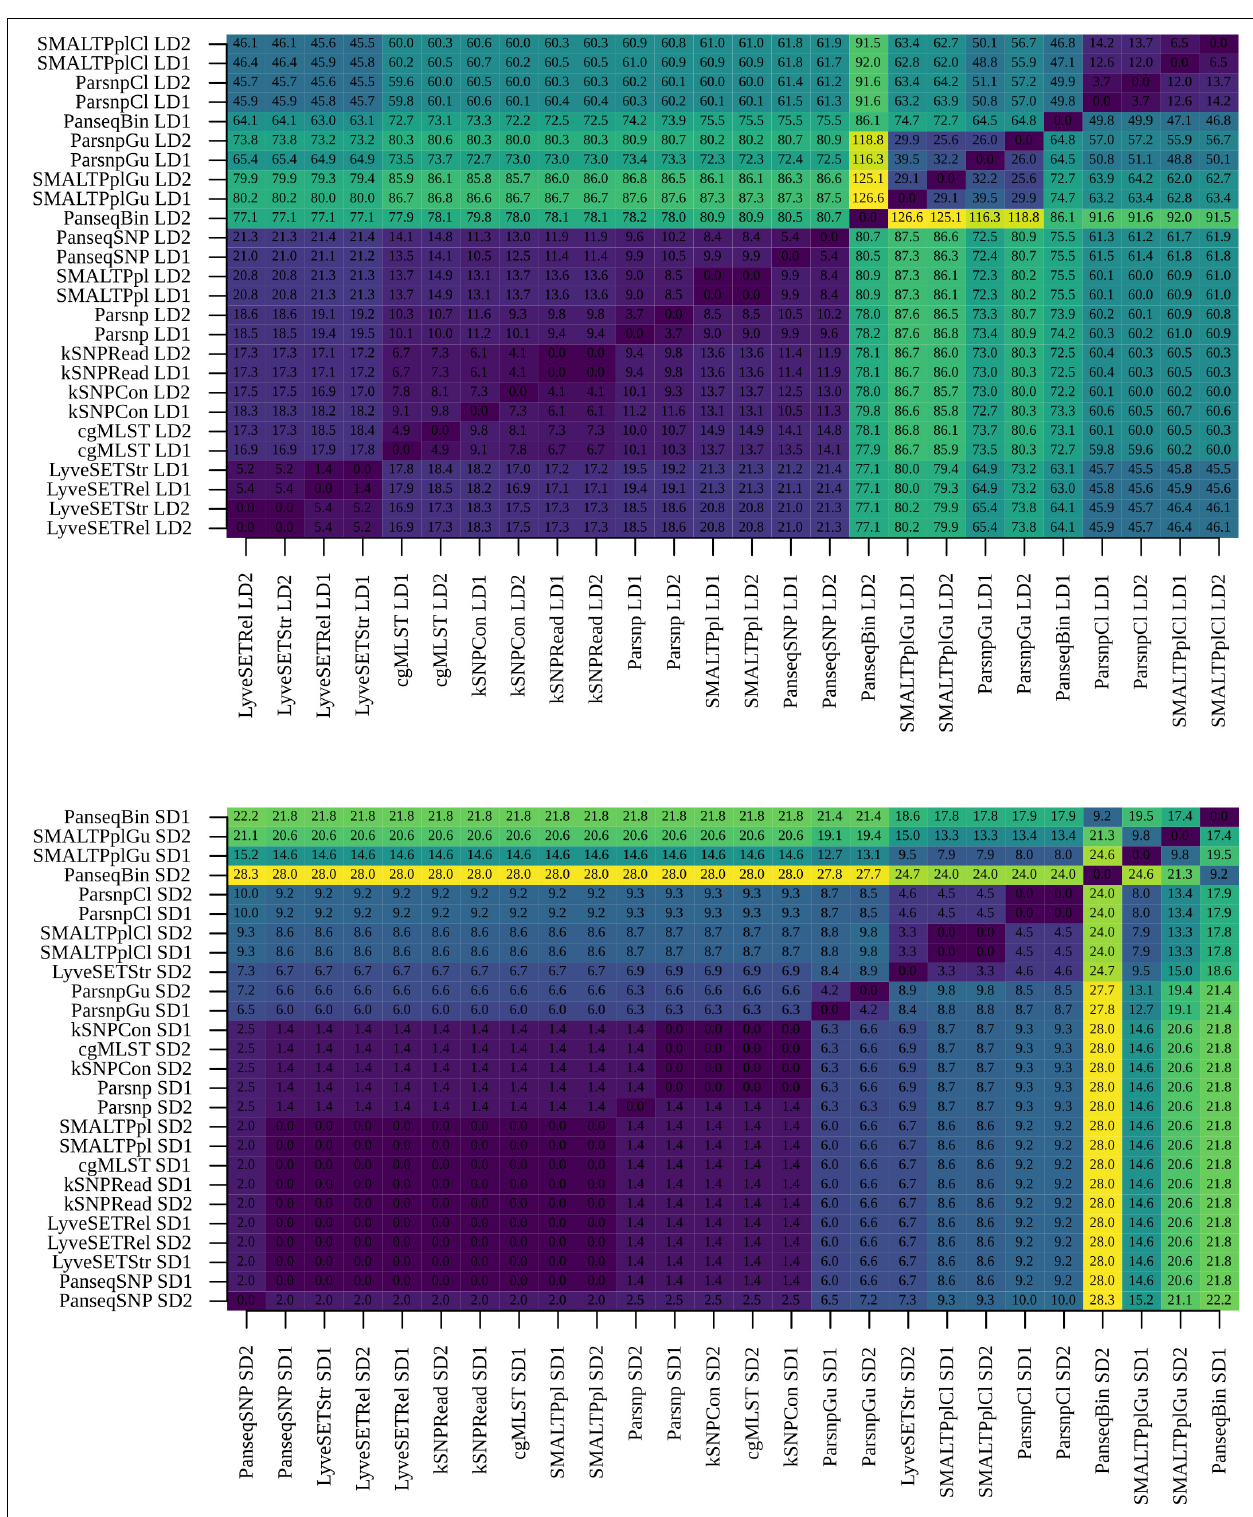
FIGURE 7 | Comparison of UPGMA phylogenetic trees between pipelines. Phylogenetic trees of SNP-based subtyping workflows were generated using the UPGMA method and compared to the cgMLST and PanseqBin phylogenetic trees using Kendall–Colijn (KC) test for topology ( λ = 0). The obtained pairwise KC distances were reported. The analysis was performed using B:NT cc-269 isolates from large datasets (LD1 and LD2) (upper panel) and small datasets (SD1 and SD2) (lower panel) .